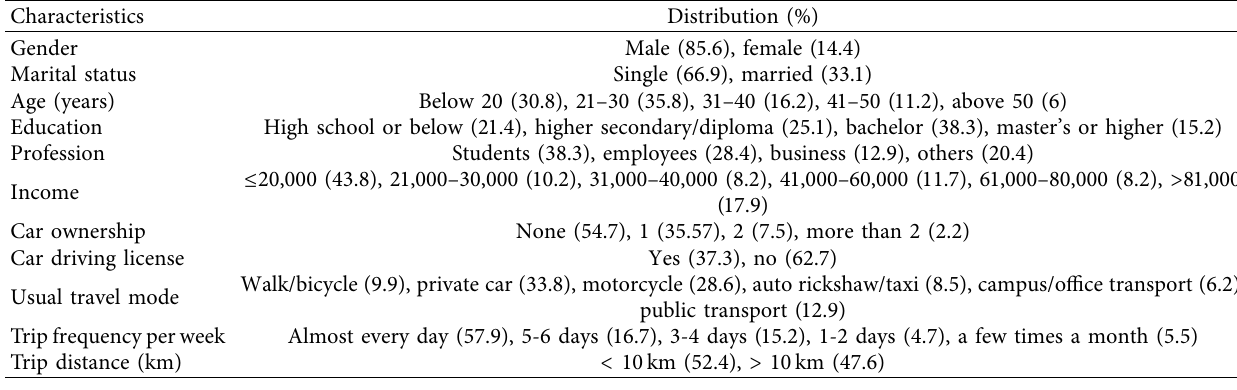
Figure 1: Framework of research hypothesis (AC: awareness of consequences, AR: ascription of responsibility, and PN: personal norm). Table 2: Descriptive statistics of the respondents’ SEDs.